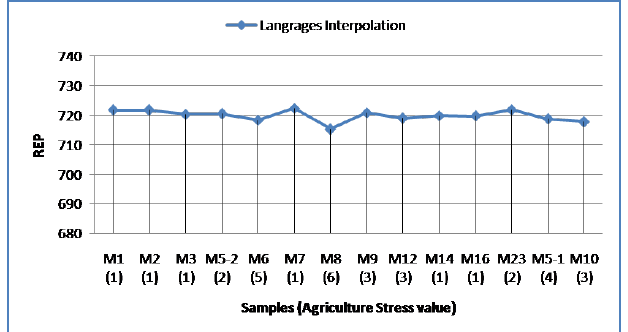
Figure 5: REP for mulberry plants using langrage’s interpolation method